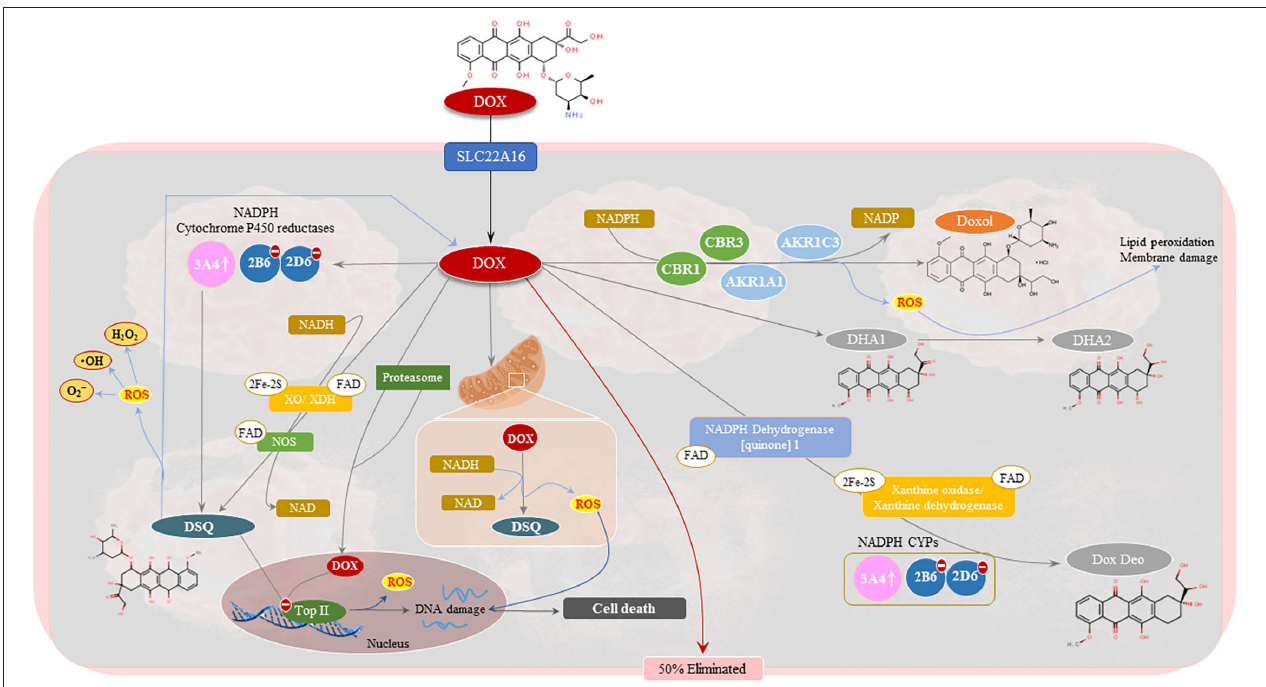
FIGURE 3 | Pharmacology of doxorubicin (Dox). Approximately 50% of Dox is eliminated from the body unchanged. The remaining Dox undergoes three metabolic processes to form doxorubicinol (Doxol), semiquinone radicals (DSQ), and 7-deoxyaglycone and hydroxyaglycone, respectively. The two-electron reduction of Dox forms Doxol via several oxidoreductases namely, carbonyl reductase 1 (CBR1) and 3 (CBR3), and aldo-keto reductases family 1 member (AKR1C3) and AKR1A1, in the presence of nicotinamide adenine dinucleotide phosphate (NADPH). Semiquinone formation entails the one-electron reduction of Dox and is mediated by mitochondrial and cytosolic NADPH dehydrogenates, xanthine oxidase (XO)/dehydrogenase (XDH), NADPH cytochrome P450 (CYPs) reductases and nitric oxide synthases (NOS). Deglycosidation of Dox, in the presence of NADPH-CYPs, XO/XDH and NADPH dehydrogenase. The formation of these metabolites is associated with DNA damage, via topoisomerase II inhibition, and the production of hydroxyl radicals ( • OH), superoxide anions (O − 2 ) and peroxides (H 2 O 2 ). This results in the activation of tumoricidal pathways which drive cancer cell